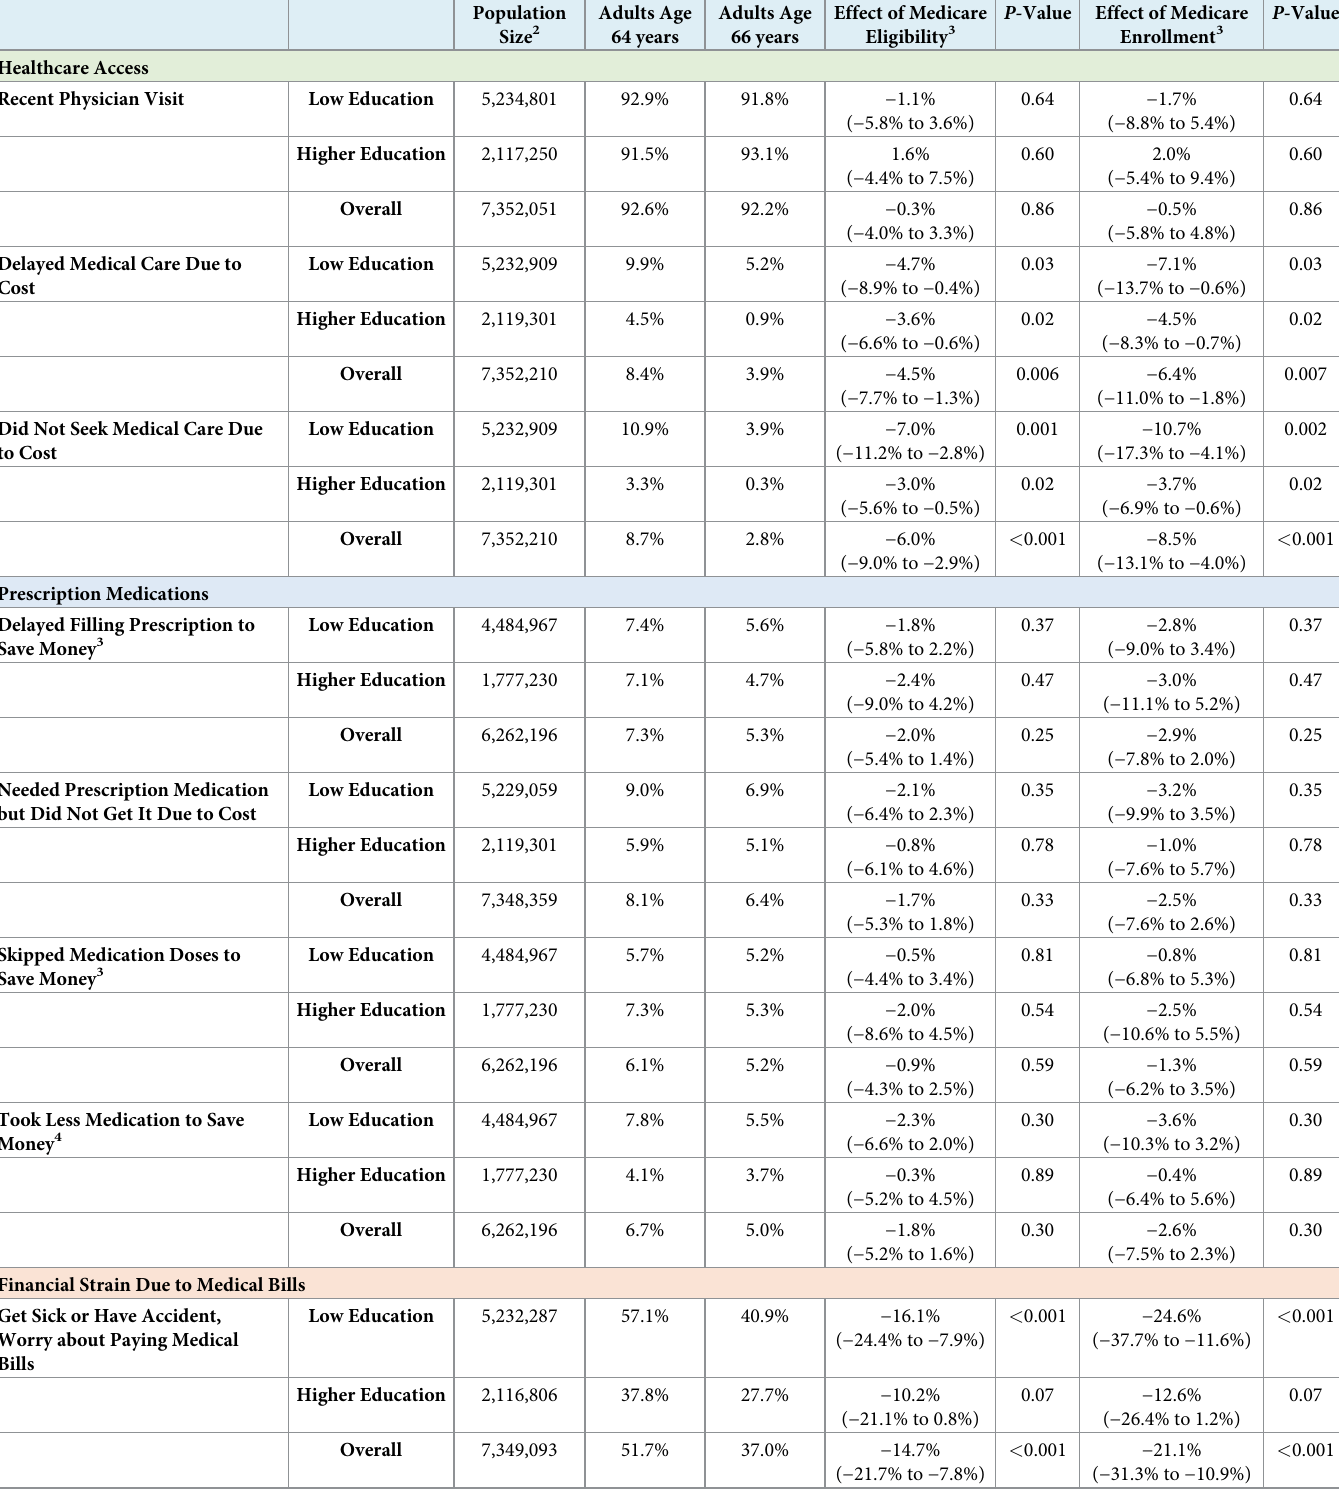
Table 5. Association of Medicare eligibility and enrollment at age 65 years on healthcare access, prescription medications, and financial strain by education level 1